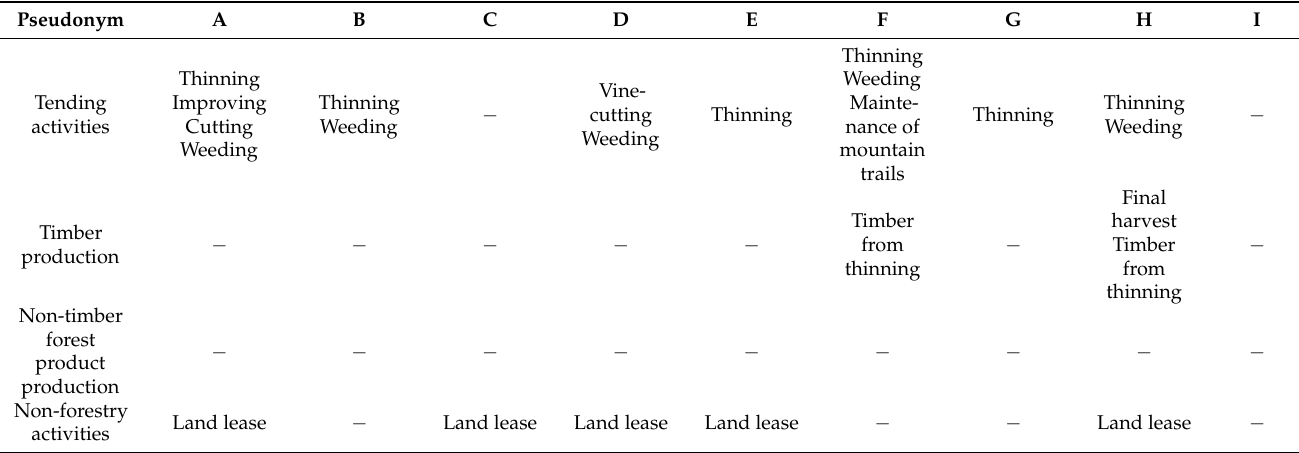
Table 2. Forest management activities among the FPCs